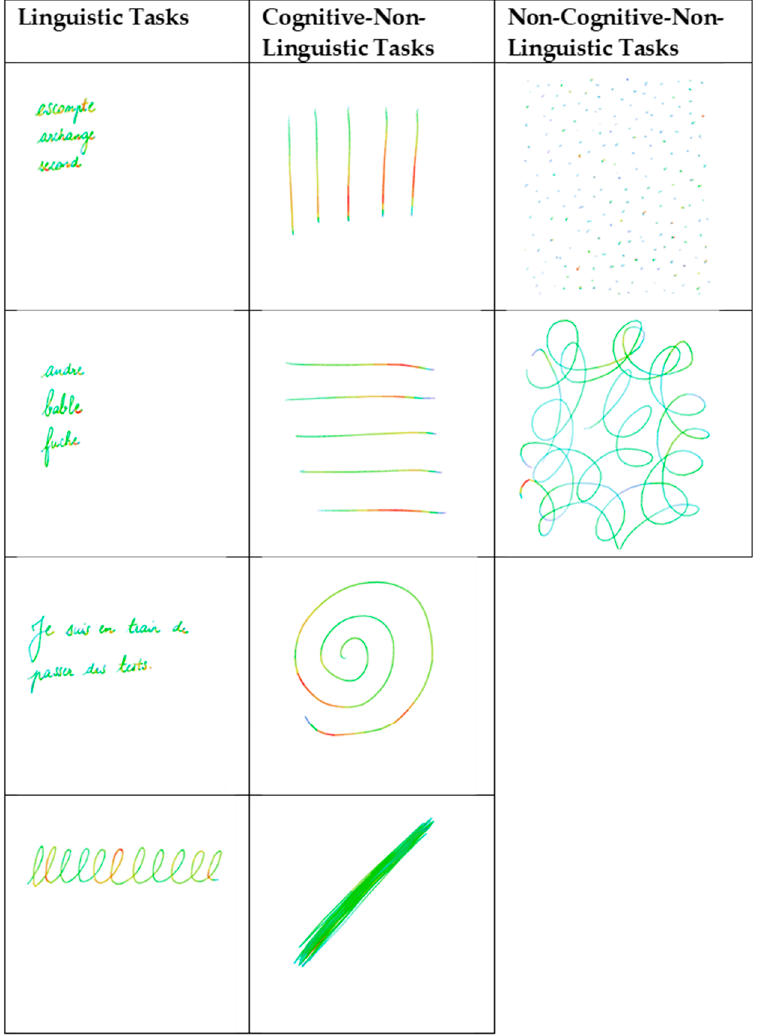
Figure 1. Graphical marker tasks. Linguistic tasks: words, nonsense words, sentence, letter ‘l’ loops. Cognitive non-linguistic tasks: vertical and horizontal lines, spiral, diagonals. Non-cognitive non- linguistic tasks: dots, filling loops. Writing pressure was collected on an iPad ® tablet. Red colour indicates the maximum pressure.